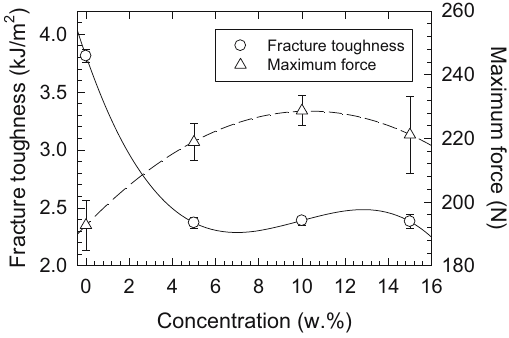
Figure 2: Young ’ s modulus of elasticity ( E ) vs perlite fi ller concen - tration. Inset: applied deformation rates.